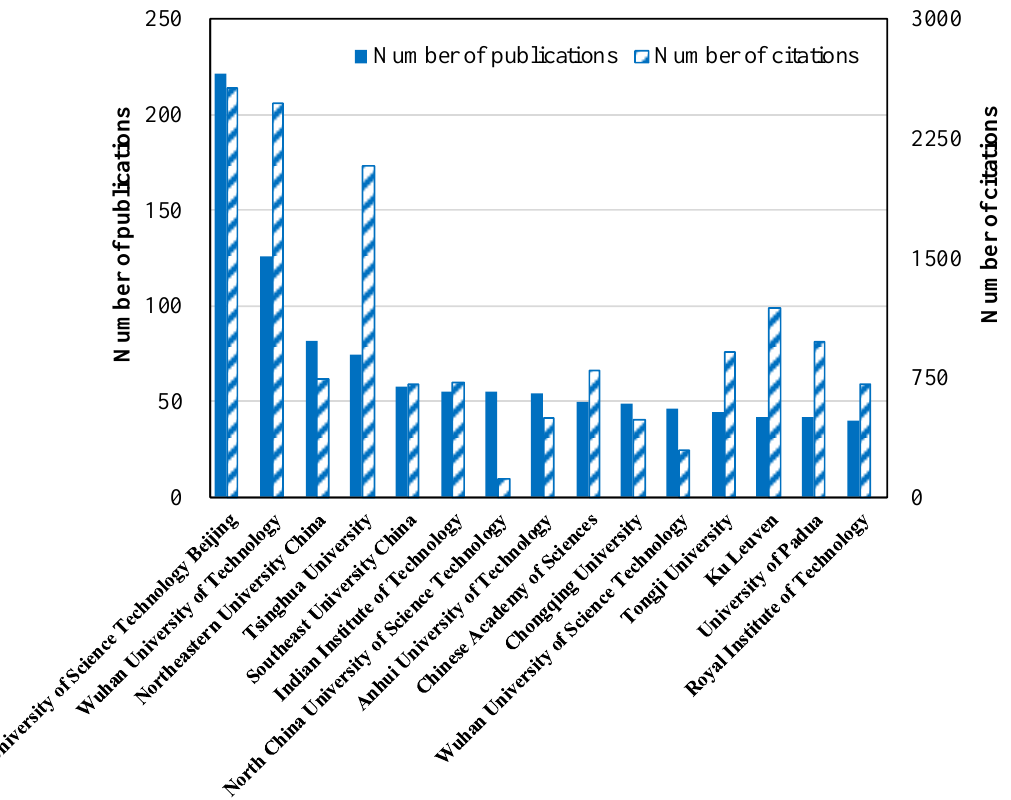
Figure 5. The number of publications and citations of the top 15 productive institutions.